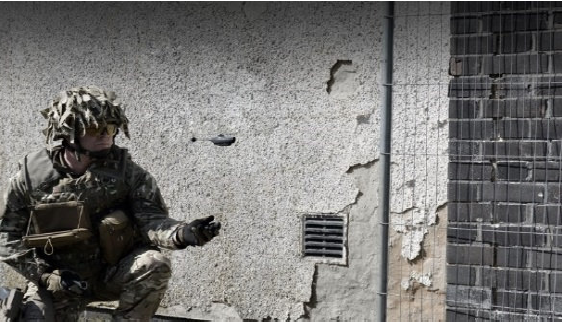
Figure 1: Black UAV Hornet Nano helicopter "photo on courtesy by